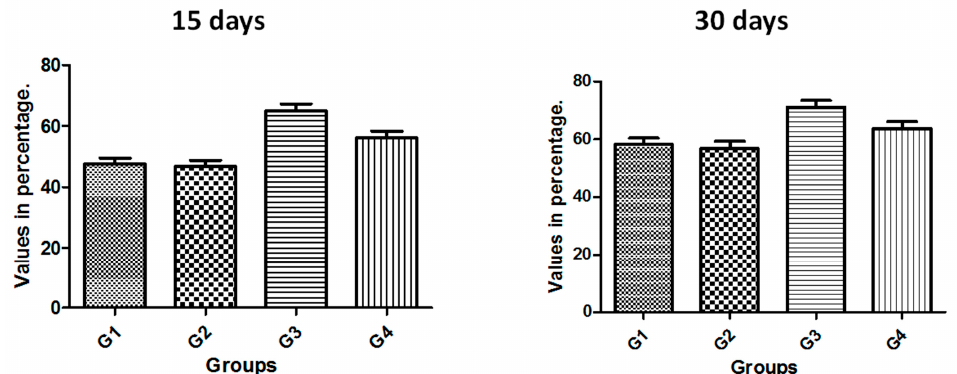
Figure 13. Bar graph of the BAFO% mean and standard deviation in the two times proposed.